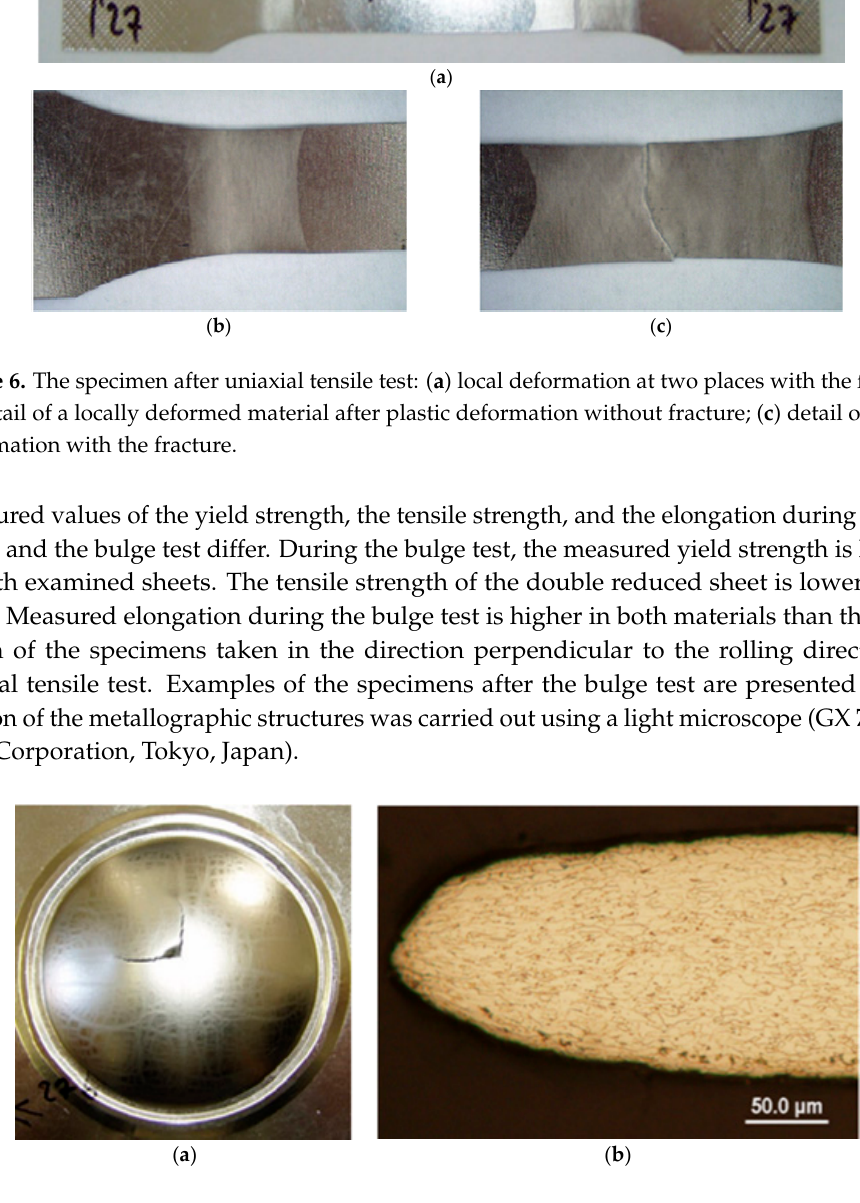
Figure 7. ( a ) Fracture of the specimen after the bulge test; ( b ) detail of the fracture area on the specimen after the bulge